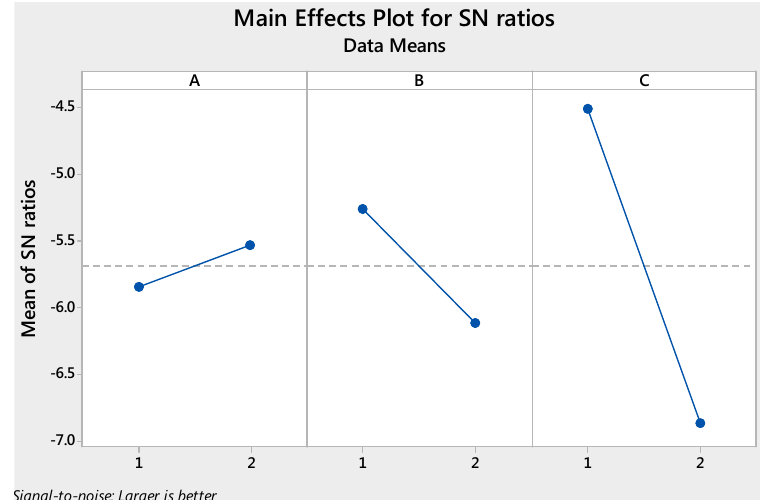
Figure 5. Level-wise response of the Grey relational grade.